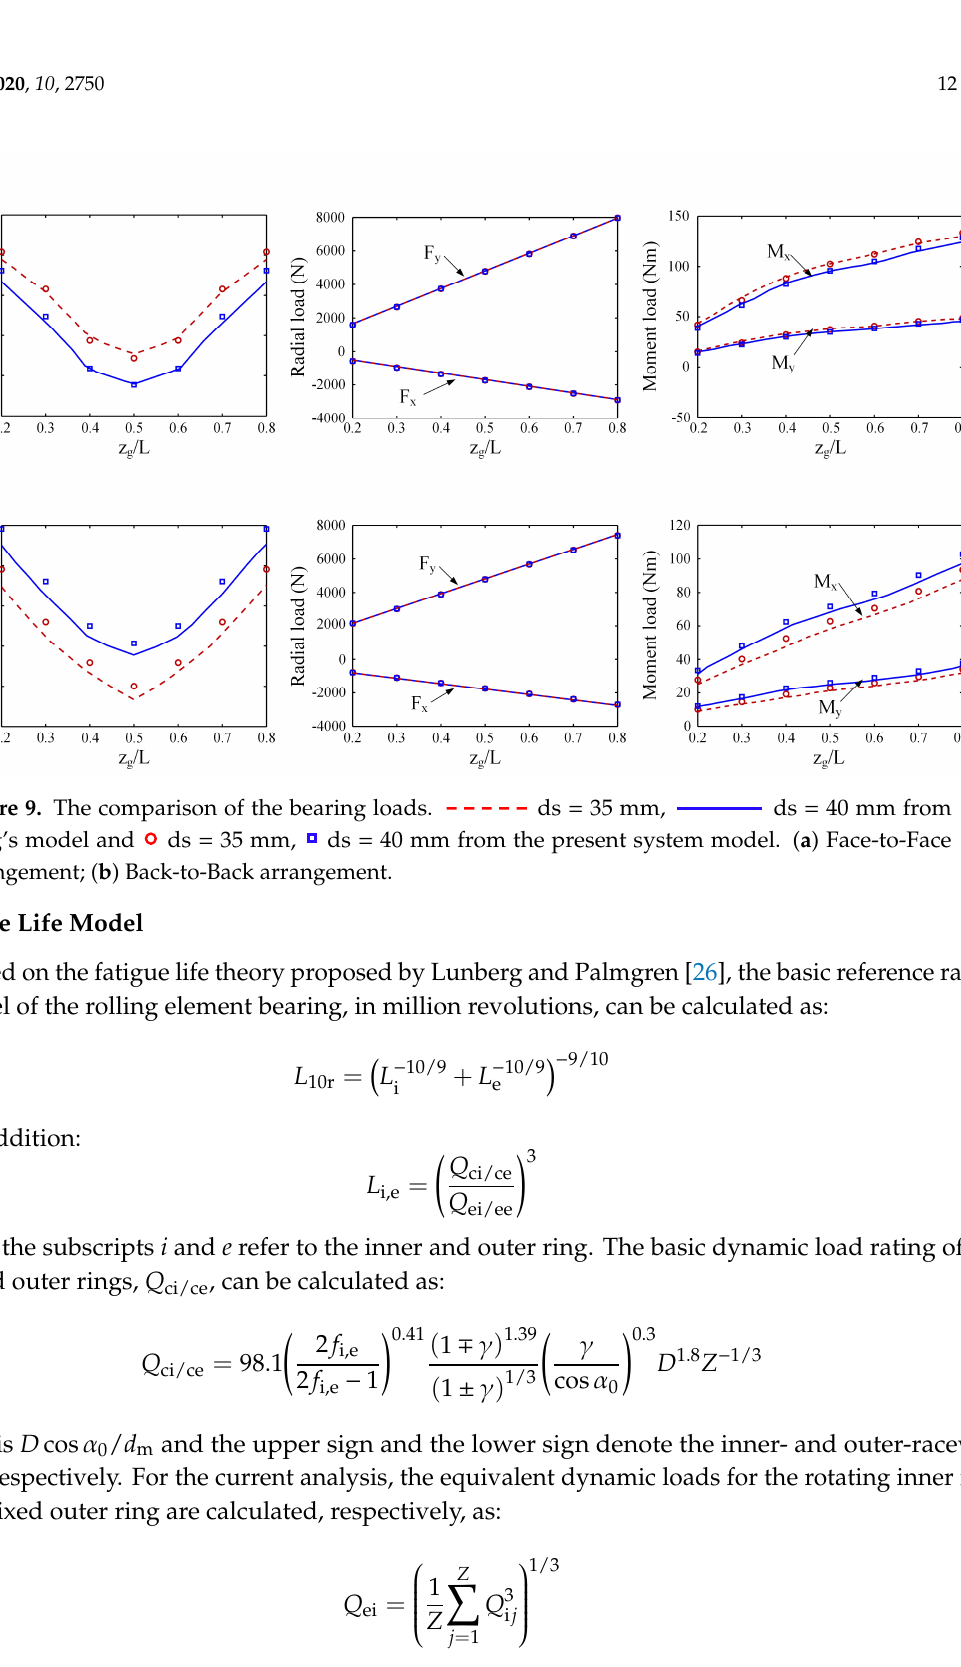
Figure 9. The comparison of the bearing loads. ds = 35 mm, ds = 40 mm from Tong’s model and ds = 35 mm, ds = 40 mm from the present system model. ( a ) Face-to-Face arrangement; ( b ) Back-to-Back arrangement.